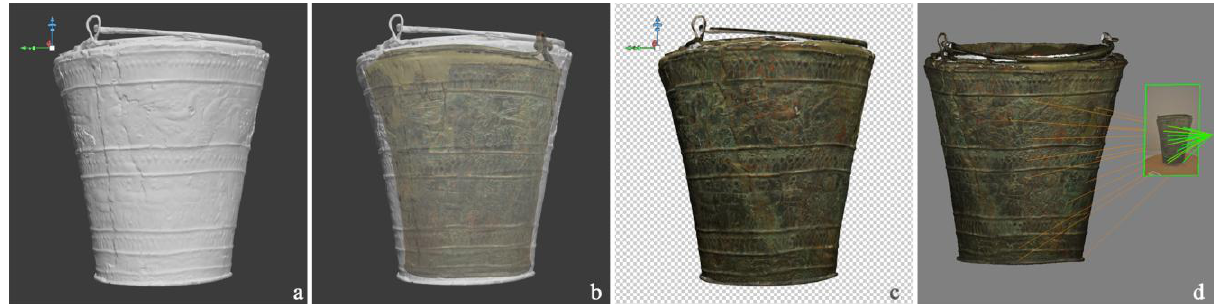
Figure 4. Texture mapping of the 3d model of the situla , using Adobe® Photoshop® ( a , b , c ). In a , imported 3d model; in b , overlapping of 2d image and 3d model. The alignment between 2d images and 3d model requires manual deformation of the image. In d , 2d image projection using 3d Reshaper®. The software calculates camera calibration parameters through the recognition of homologues points on 3d surface and 2d